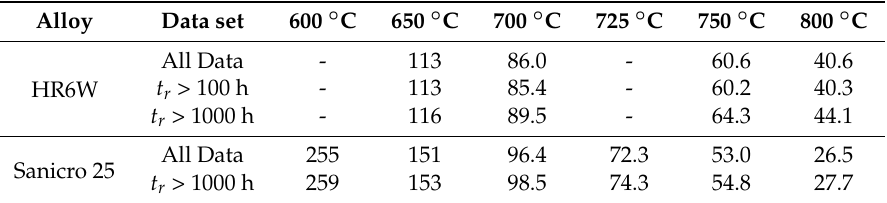
Table 13. Calculated creep strength for rupture at 100,000 h (MPa).